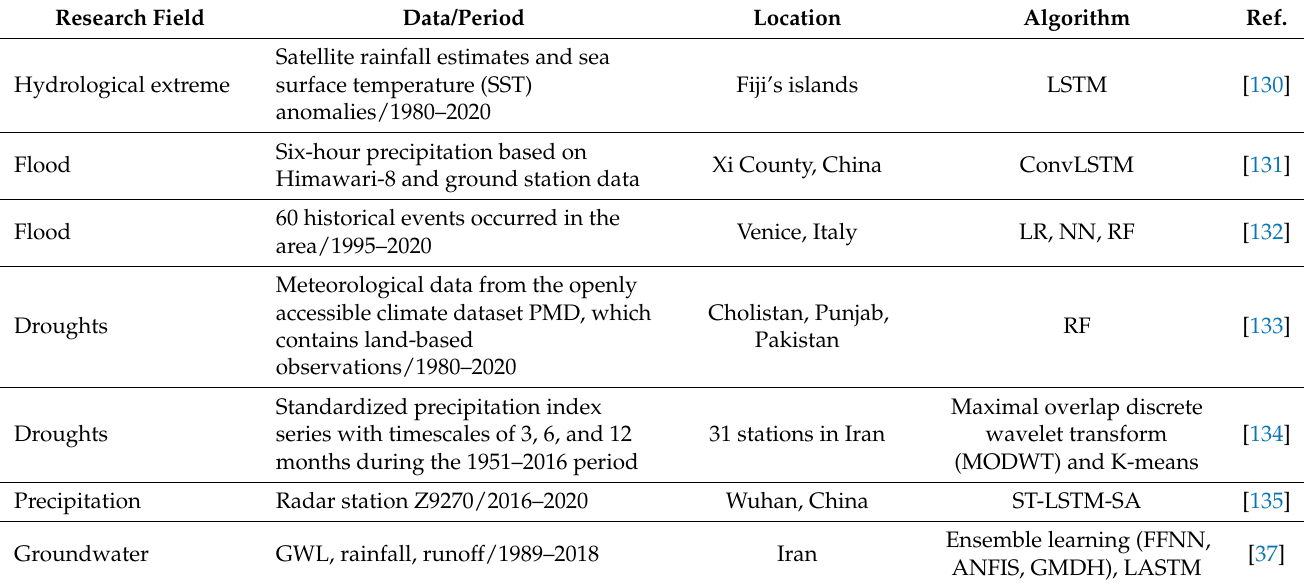
Table 7. State-of-the-art applications of ML to spatiotemporal studies.